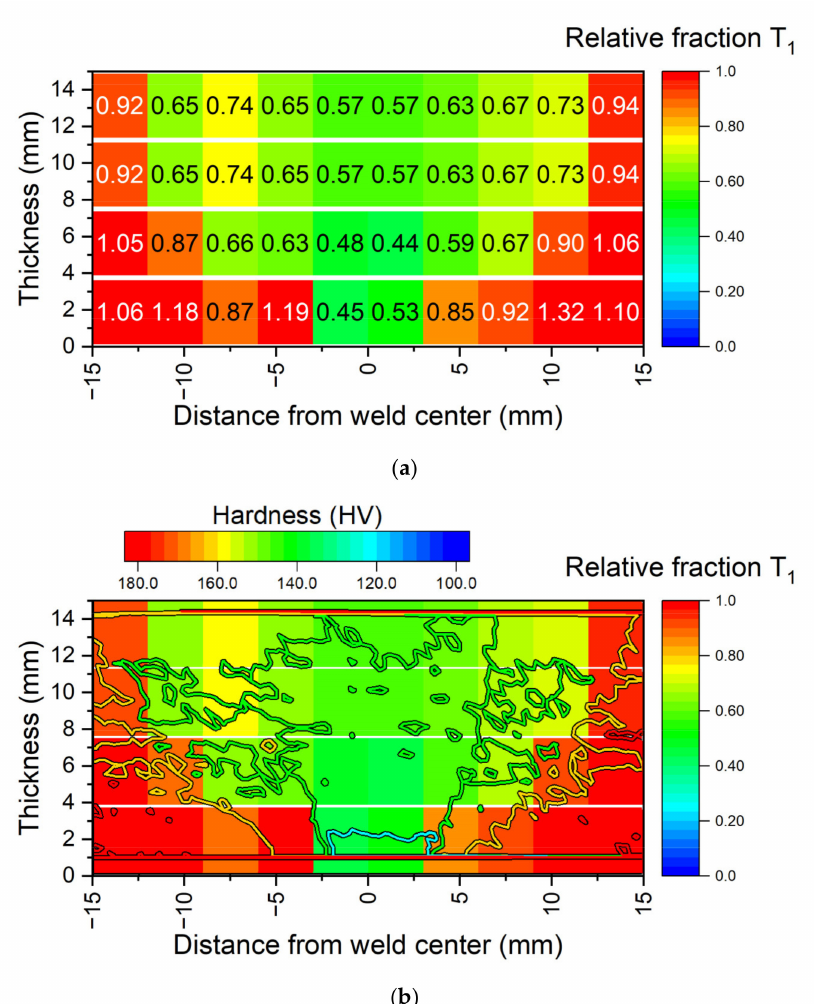
Figure 5. The map of the relative volume fraction of the T 1 phase in FSW weld cross-sections after the post-welding heat treatment of 30 h at 155 ◦ C: ( a ) T 1 phase map with figures representing the relative volume fraction originate from the multi-point resistivity measurements. ( b ) T 1 phase and hardness map. The hardness is marked with an isoline